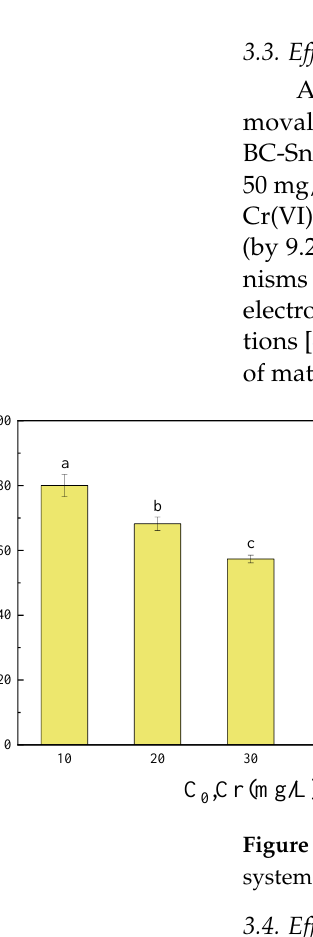
Figure 4. Isothermal adsorption of ( a ) Cd(II) and ( b ) Cr(VI) on BC-SnZVI in single or binary sys- tems.